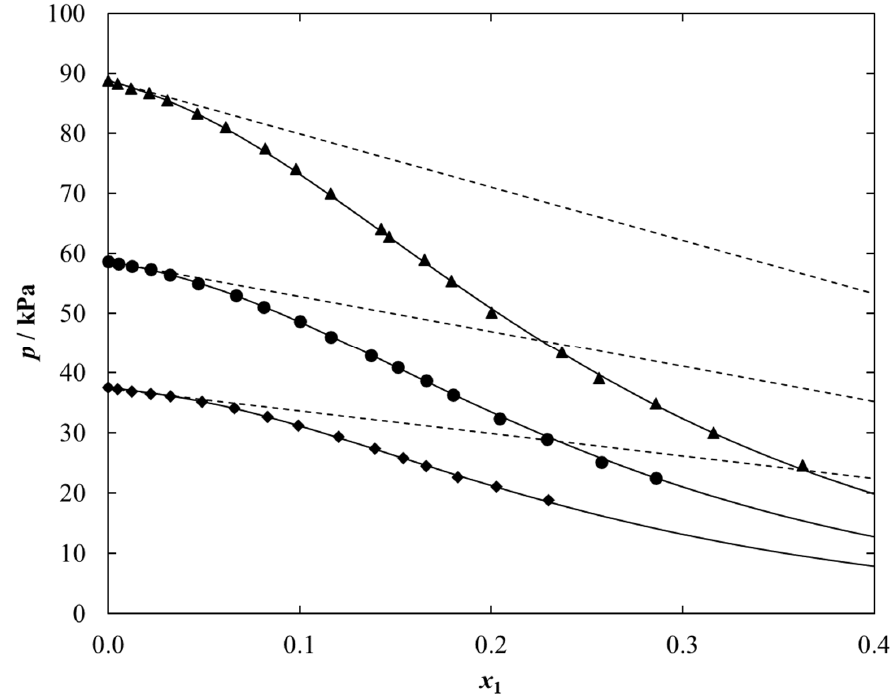
Figure 2. Plot of the experimental and calculated P – x data for {[C 1 C 2 MOR][DMP] (1) + Ethanol (2)} vs. ionic liquid mole fraction, x 1 , at different temperatures, T : ♦ , 328.15 K; ● , 338.15 K; ▲ , 348.15 K. Full points ‐ experimental data; solid lines ‐ NRTL equation with parameters given in Table 5; dashed lines ‐ ideal solution. Table 5. NRTL parameters fitted to experimental VLE data of {IL (1) + Ethanol (2)} with the average absolute deviation (AAD) and for the systems studied.